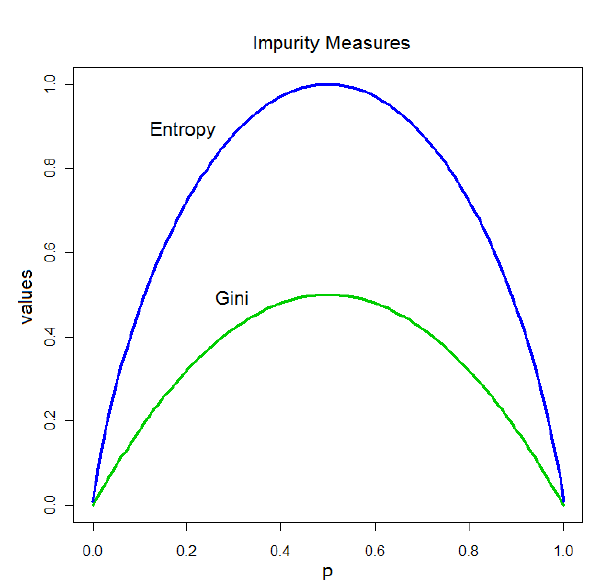
Figure 1. Impurity measures for two classes as function of the proportion of one of them p , probability values close to the extremes decrease uncertainty in the